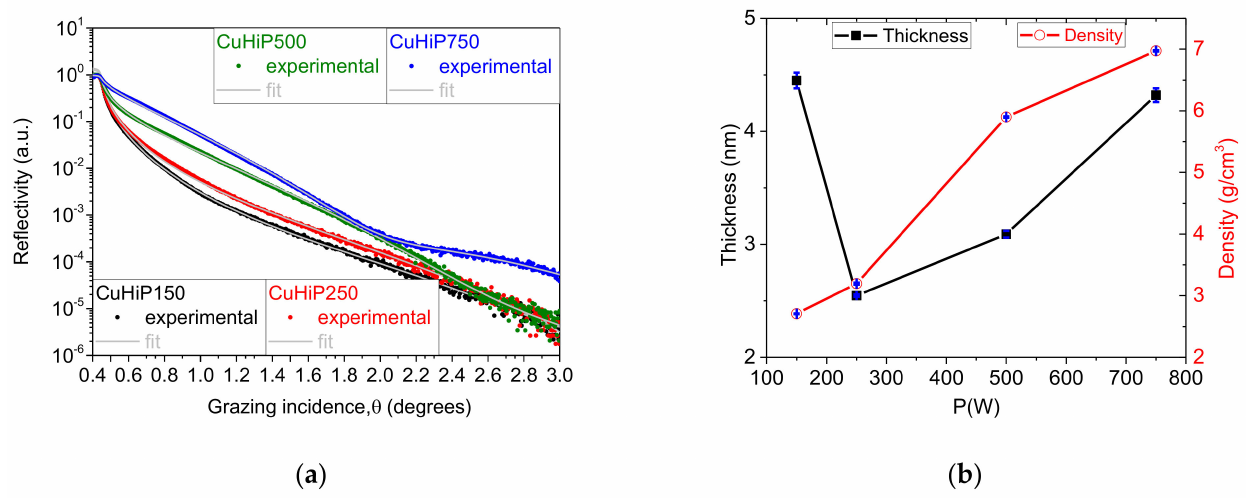
Figure 3. XRR spectra of Cu thin films deposited at 4 power settings of HIPIMS (scattering), and the fitting of the spectra (full line) ( a ); along with the resulted density and thickness variation as a function cathode power fed ( b ).